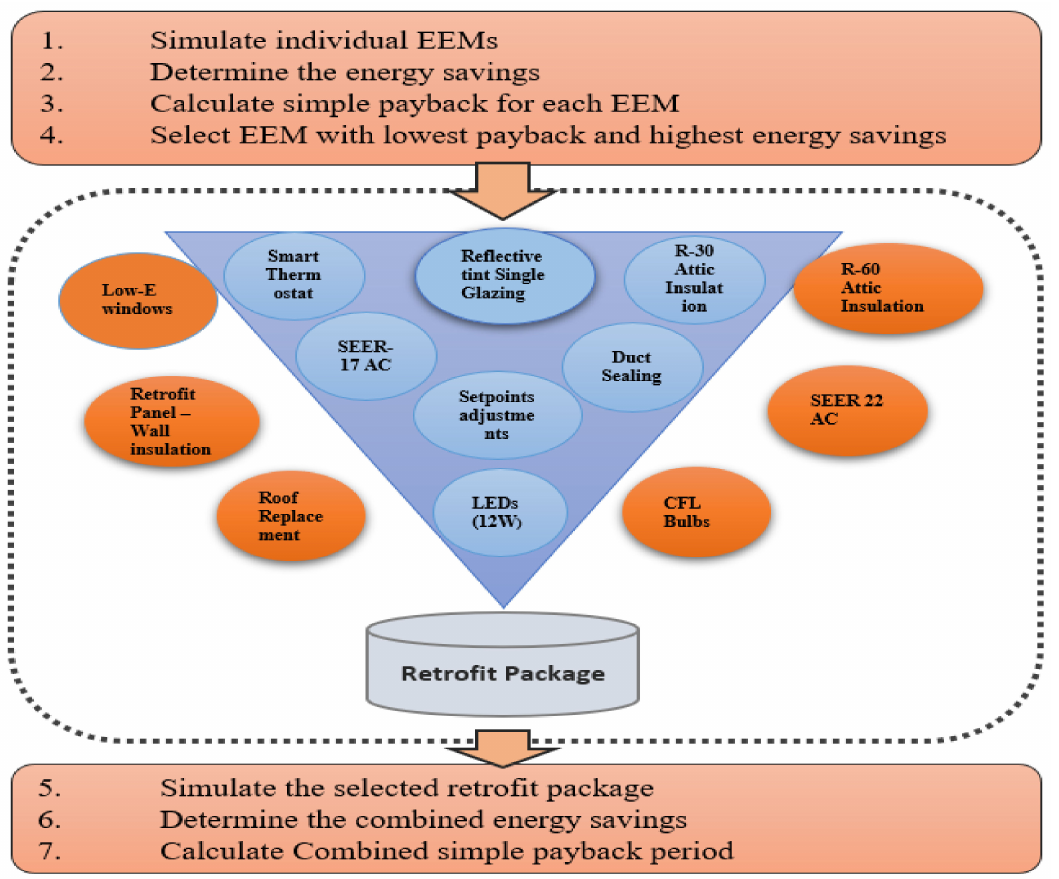
Figure 15. Demonstration of automated process used to develop customized retrofit package of energy e ffi ciency of individual EEMs for SFR